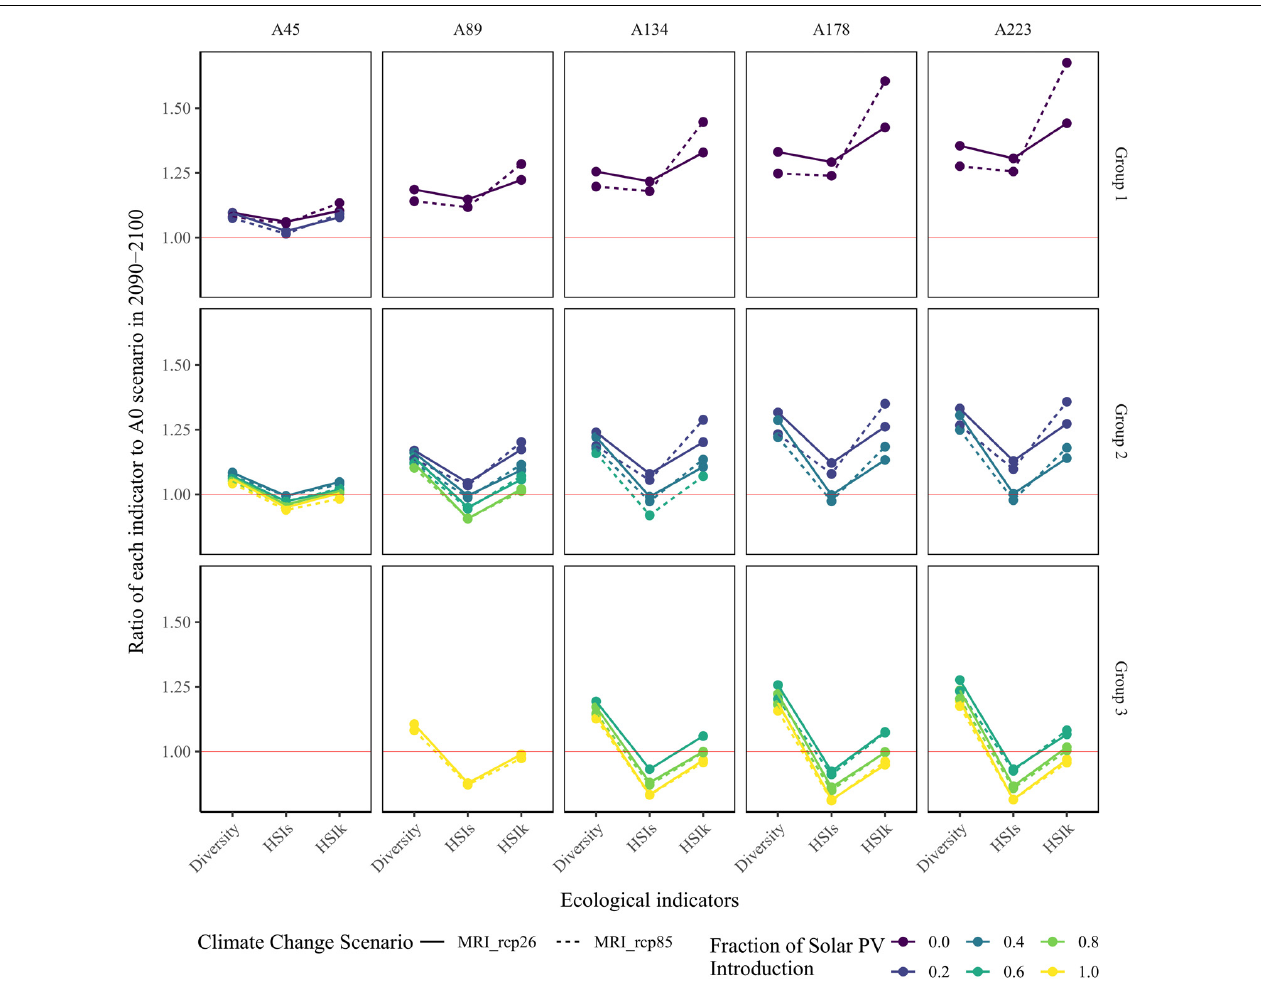
FIGURE 4 | Ratio of each ecological indicator to the no pastureland abandonment scenario (A0) from 2090 to 2100 by pastureland abandonment expansion speed and level of renewable energy production. The red line indicates the same indicator value as the A0 scenario. Values over 1.0 indicate that the ecological indicators are better than the A0 scenario. Three scenario groups were identified based on the balance between renewable energy (RE) supply and demand: group 1, where energy production is less than energy demand; group 2, where RE production satisfies the energy demand and is less than five times the demand; and group 3, where RE production satisfies the energy demand and is more than five times the RE demand. Diversity = Shannon–Wiener diversity index, HSI s = habitat suitability index for the mountain hawk-eagle ( Spizaetus nipalensis orientalis ), HSI k = habitat suitability index for Blakiston’s fish owl ( Ketupa blakistoni blakistoni ). A0–A223 represents the pastureland abandonment expansion speed, and the colors indicate the solar PV plant fraction ( Table 1 ).